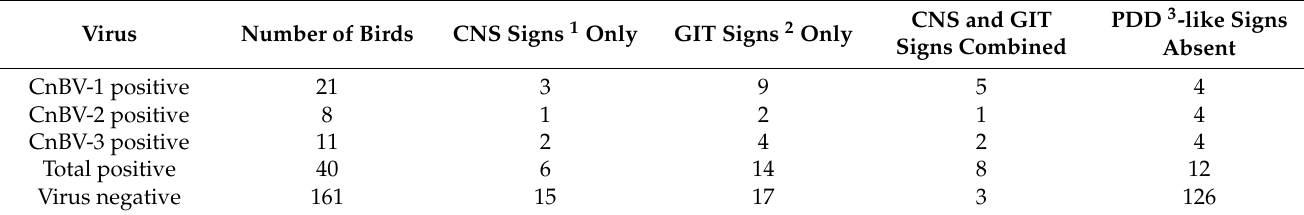
Table 2. Occurrence of canary bornavirus types and PDD-like signs in 201 canaries. Virus